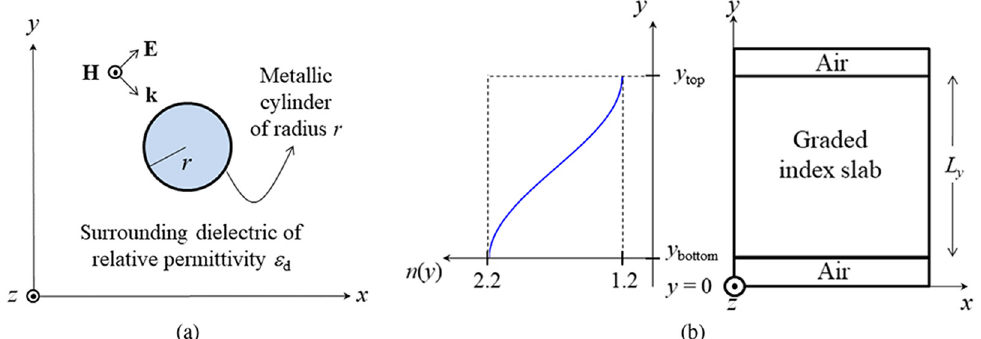
Fig. 2. Schematic diagram of (a) a metallic rod surrounded by a dielectric of relative permittivity e d = n 2 , and (b) a slab sandwiched by air on both sides, and having the graded index pro fi le n ( y ) shown at the